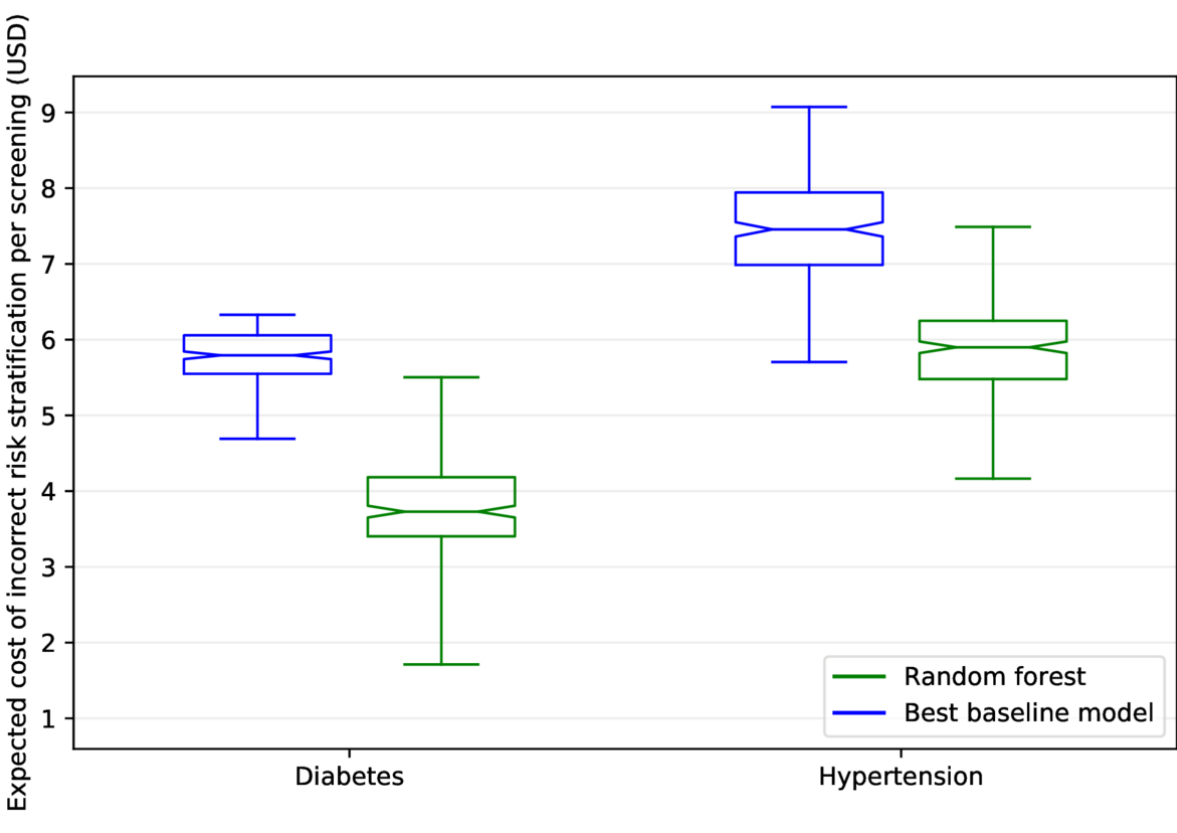
Figure 4. A comparison of the expected cost of incorrect risk stratification per screening across 250 test sets between the random forest and best baseline approach for both diabetes and hypertension. The random forest reduced the expected cost of incorrect risk stratification by US $1.99 per screening for diabetes (US $5.76 vs US $3.77, P <.001) and by US $1.60 per screening for hypertension (US $7.47 vs US $5.87, P <.001). The upper and lower boundaries of the boxes correspond to the first and third quartiles, respectively. The line inside the box represents the median, the whiskers correspond to the minimum and the maximum of the distribution, and the notches in the box represent the 95% confidence interval around the